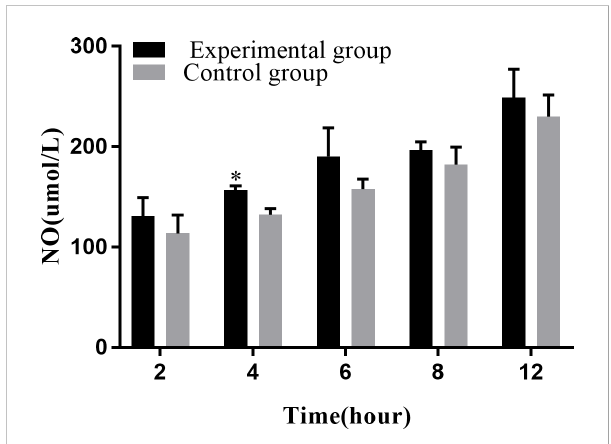
FIGURE 7 Levels of NO release at different time periods. The NO release assay was repeated thrice, and each experiment was performed in triplicate. Results are presented as mean ± SD. * P <0.05, compared with the control